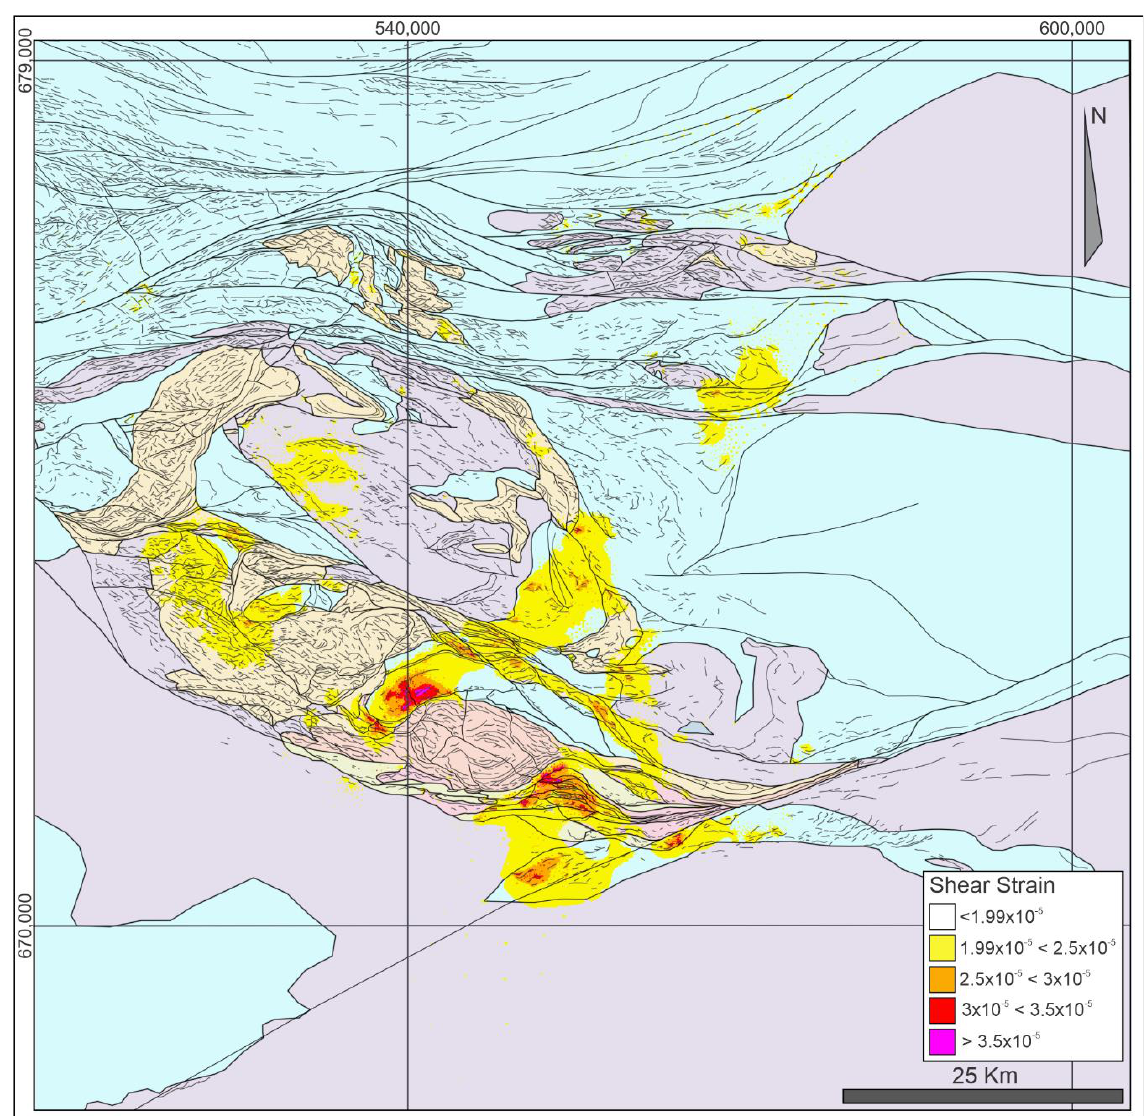
Figure 10. Shear strain superimposed on the structural–lithological interpretation. Areas of particularly high shear strain occupy regions of favourably orientated and interleaved tectonostratigraphy in proximity to—and adjacent to—the large gabbro-gabbrodiorite body in the southern extent of the Mt. Woods Inlier.